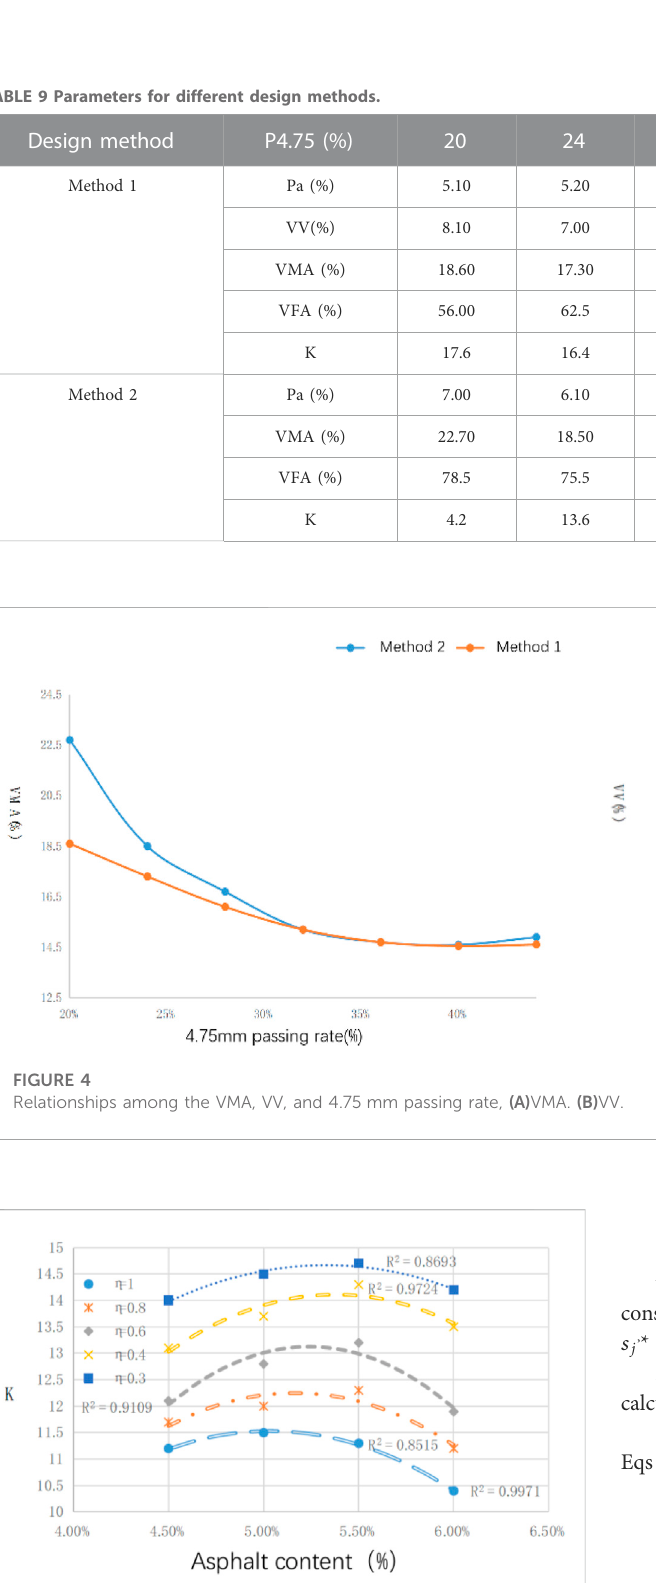
FIGURE 5 K values for different asphalt